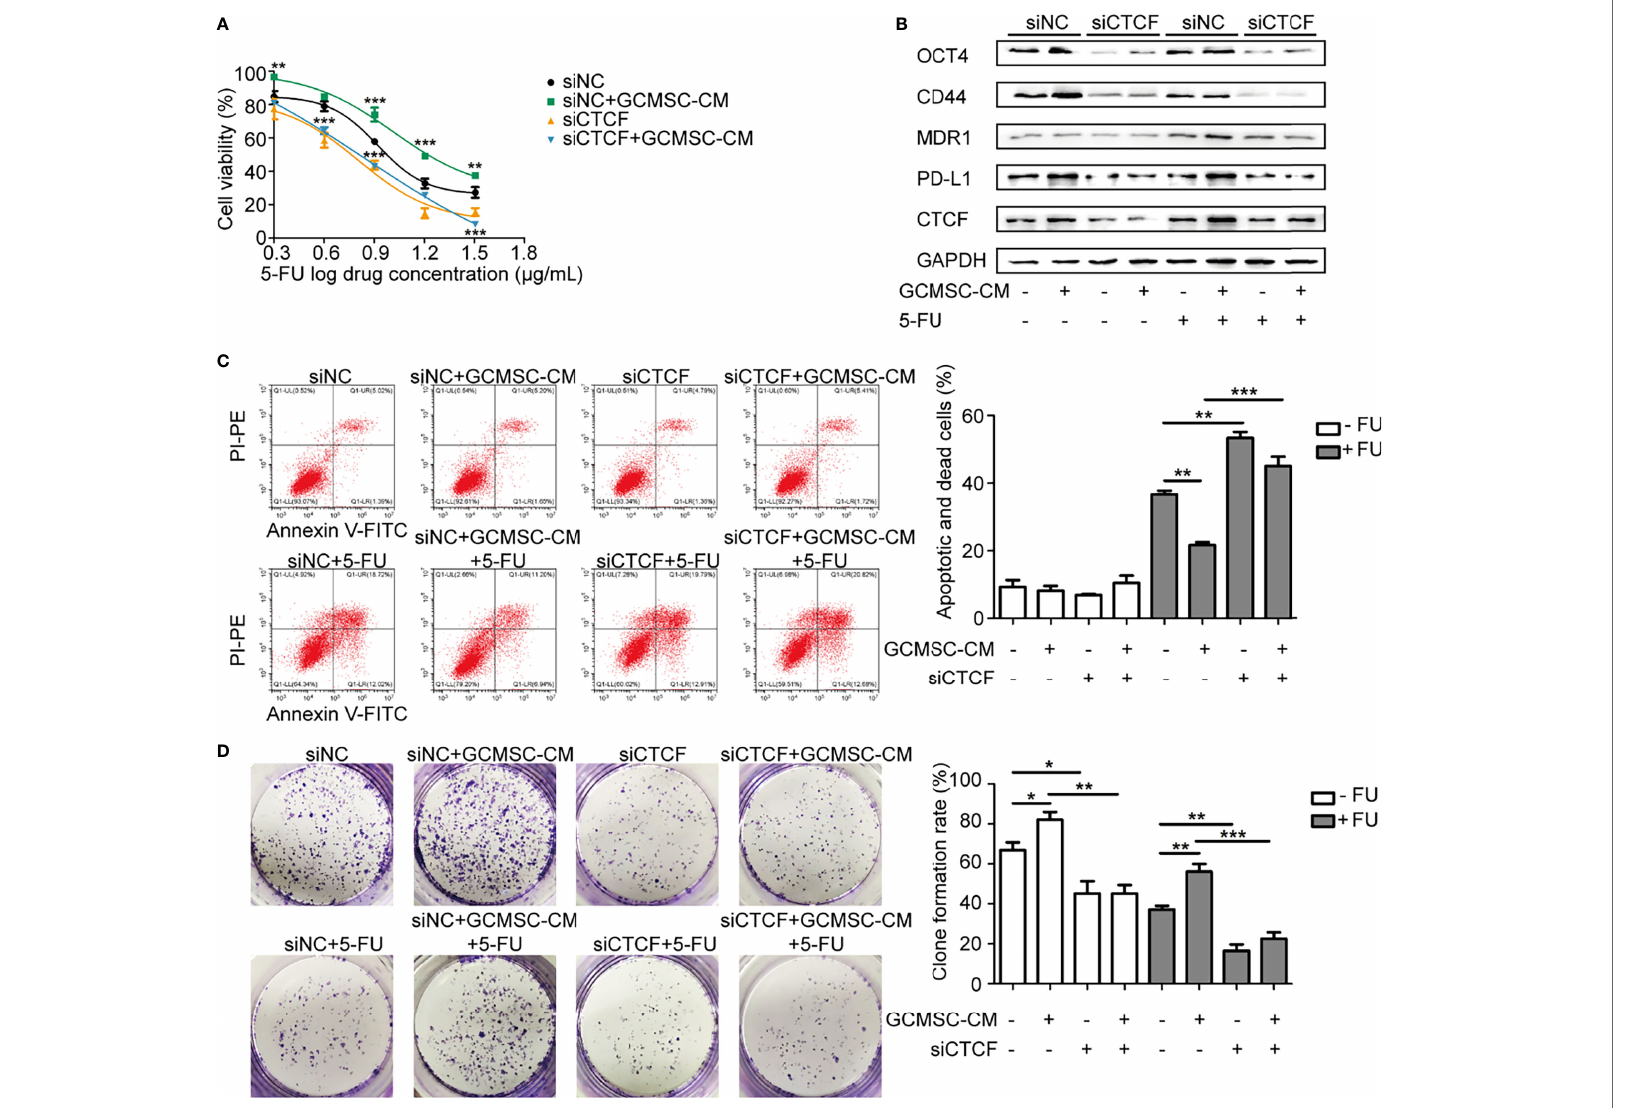
FIGURE 3 | CTCF is essential for maintenance of cell stemness and high expression of PD-L1 caused by GCMSC-CM. CCK-8 (A) , Western blot (B) , fl ow cytometry (C) , and colony-forming assay (D) were performed in siCTCF HGC-27 cells following GCMSC-CM and 5-FU treatment. Panels on the right are quanti fi ed images. * p < 0.05, ** p < 0.01, *** p <